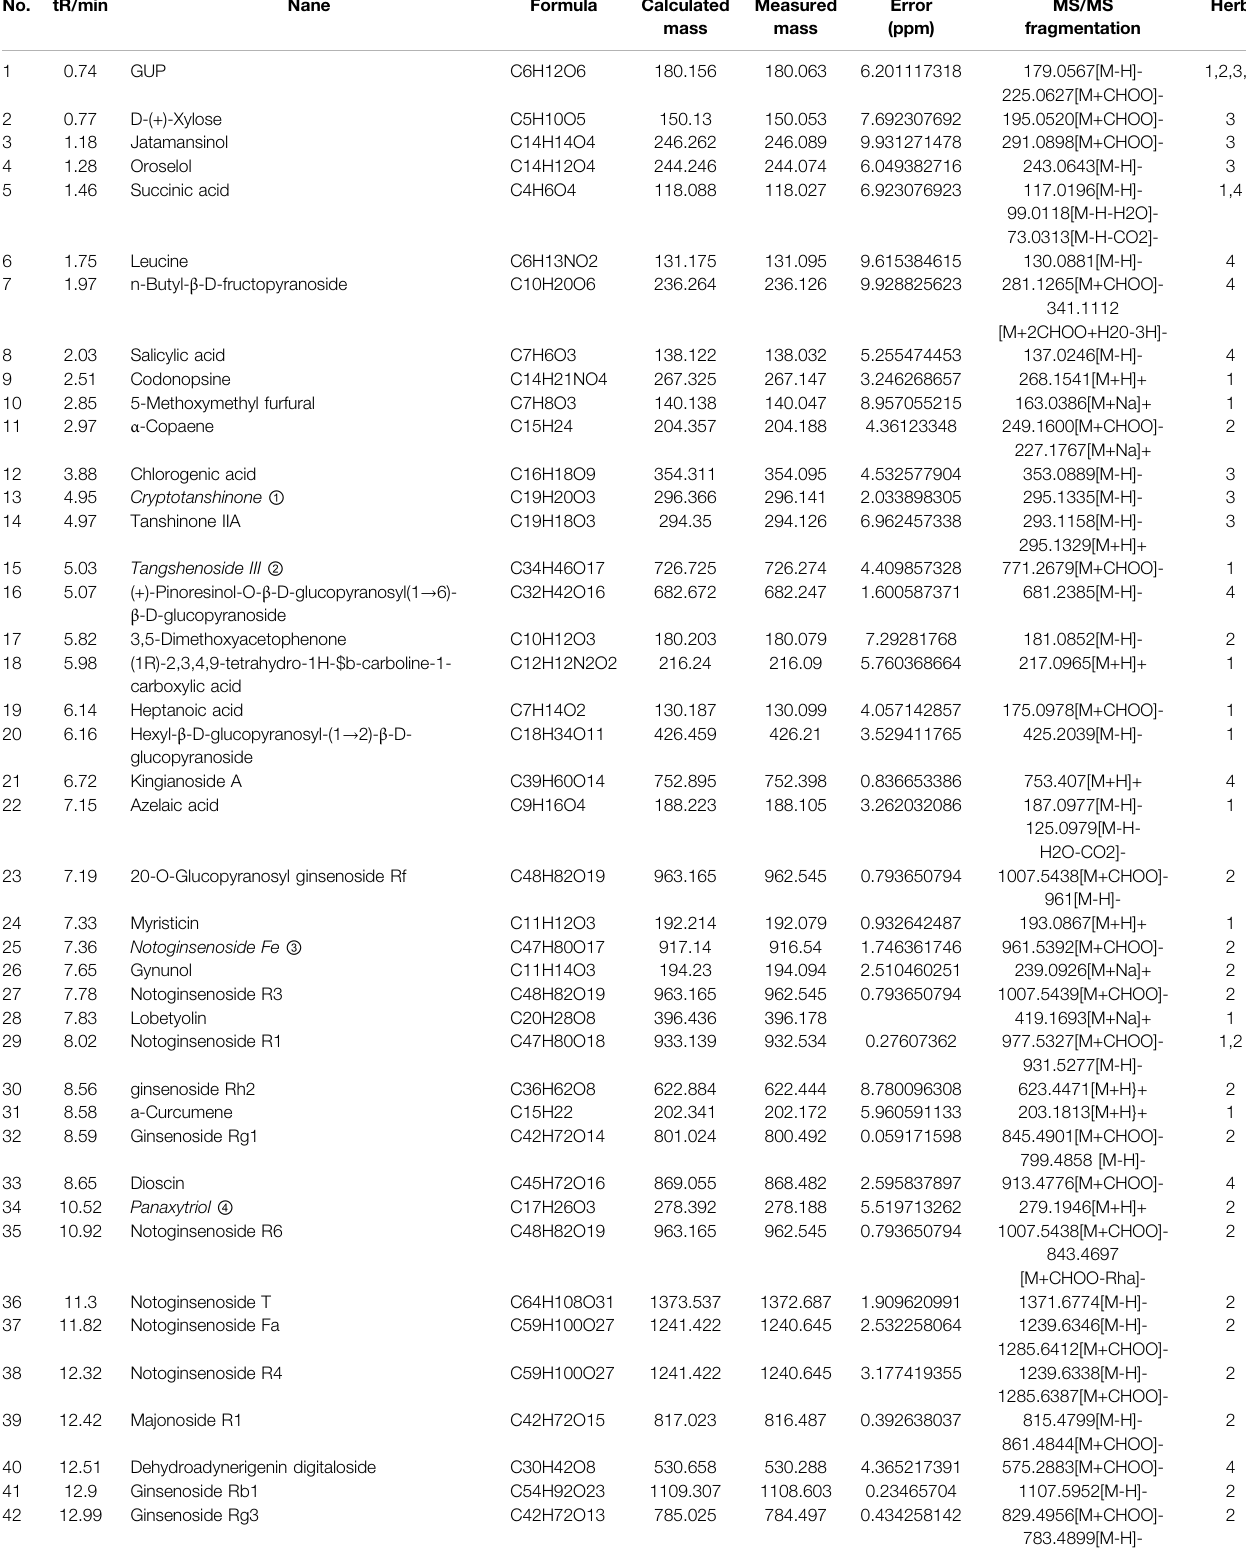
TABLE 1 | Main components of WK aqueous